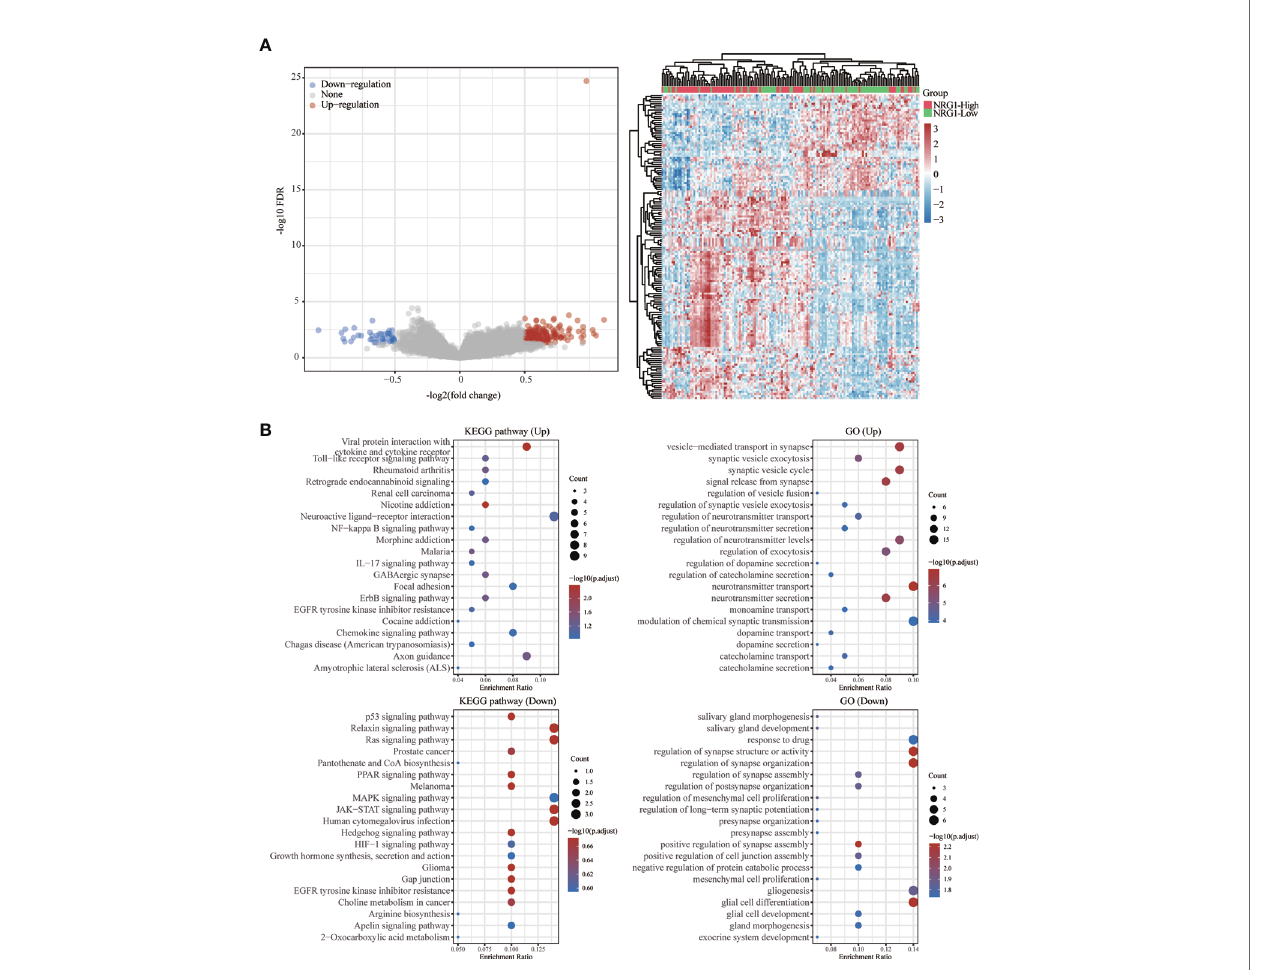
FIGURE 13 | Functional enrichment for gene set associated with high/low expression of NRG1 in patients with GBM. Differentially expressed genes for high expression of NRG1 vs low expression of NRG1 in GBM were shown in the volcano plot (A) , with blue dots representing signi fi cantly down-regulated genes and orange dots representing signi fi cantly up-regulated genes in GBM with high expression of NRG1. The heatmap exhibits the expression level. Enrichment analysis for KEGG pathway and GO term of down-regulated genes and up-regulated genes in GBM with high expression of NRG1 (B) .